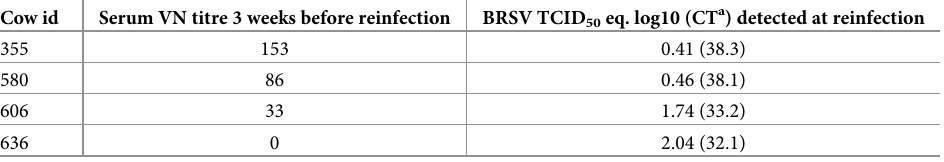
Table 3. Serum BRSV neutralising (VN) titre three weeks before detection of natural BRSV reinfection of cows, four years after a previous infection. BRSV RNA detected at reinfection in nasal